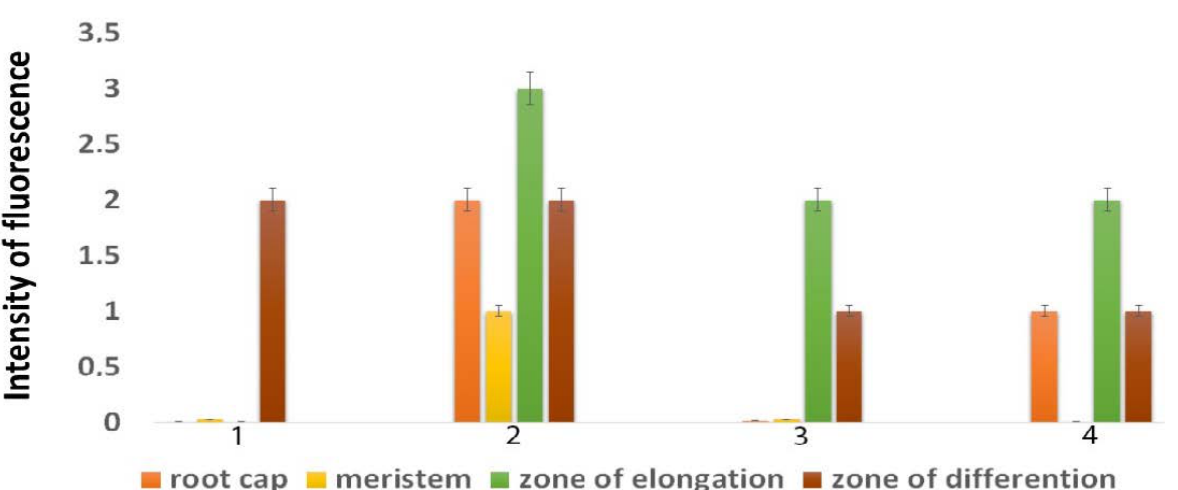
Figure 4. Intensity of fluorescence of ROS cells in the zones of 28 days tobacco roots. (1) Control; (2) in the presence AEDL; (3) in the presence 150 mM NaCl; (4) in the joint presence AEDL and 150 mM NaCl. Standard deviations are shown according to Student’s criterion, p < 0.05.